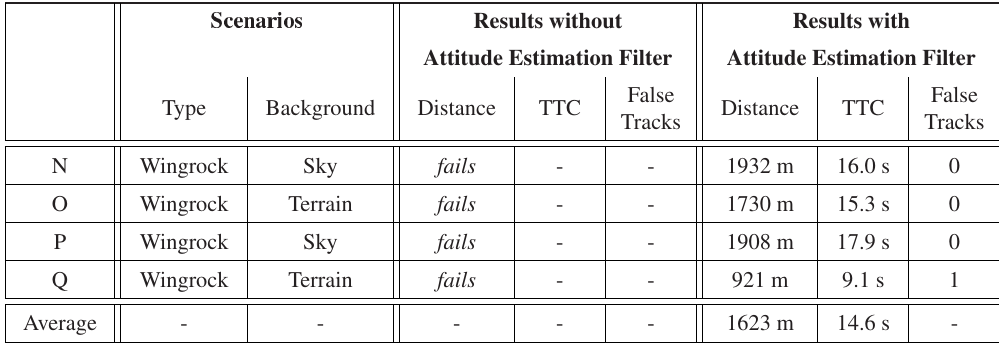
Table 2: Evaluation of the aerial object tracking framework with the attitude estimation filter. For each scenario we show the remaining distance once the incoming traffic aircraft is successfully tracked, the remaining time to collision (TTC) and the total number of false tracks during the scenario. Note that for the evaluation without attitude estimation filter the traffic aircraft is detected as well, but the tracking framework fails to create a consistent track.